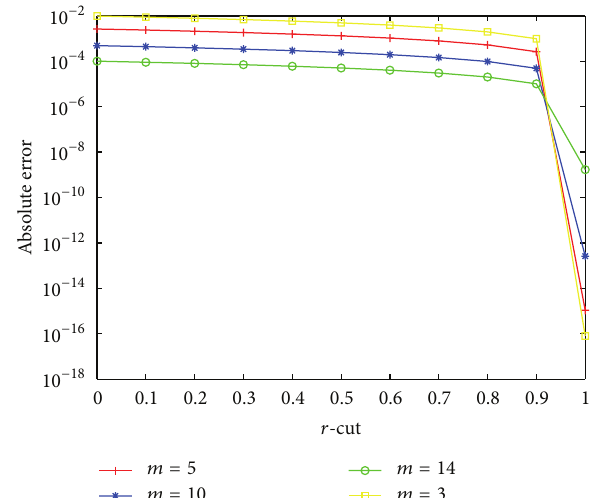
Figure 13: The absolute error for different 𝑚 of Example 60, 𝛼 = 0.75